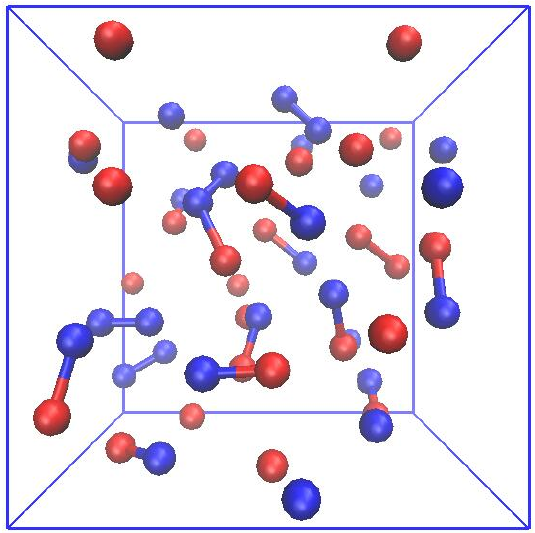
Figure 4. Snapshot of the AIMD simulation at 2.85 g cm − 3 and 5168 K from the AIMD calculation using 27NO molecules and PBE functional, red and blue spheres represent oxygen and nitrogen atoms, respectively.